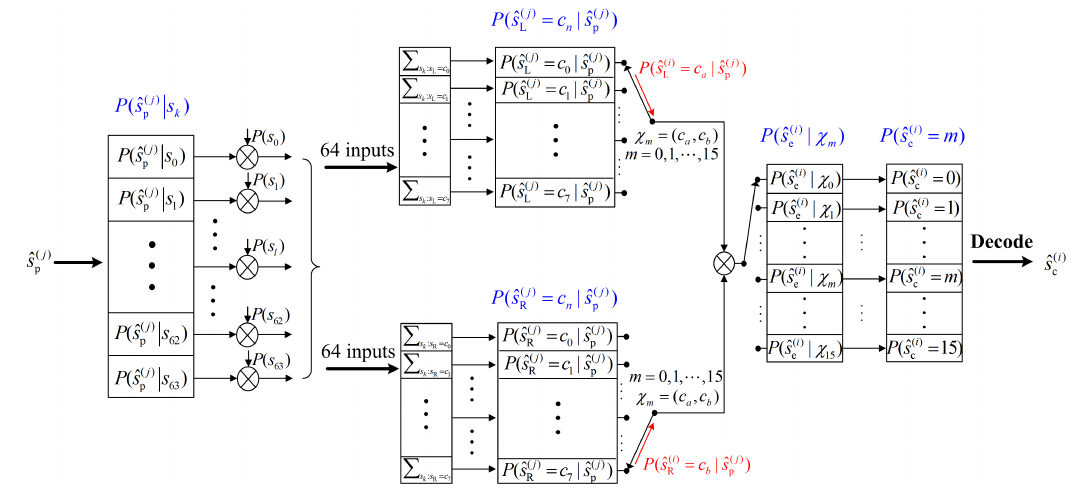
Figure 6. The demapping process for the nonequiprobable 64-QAM